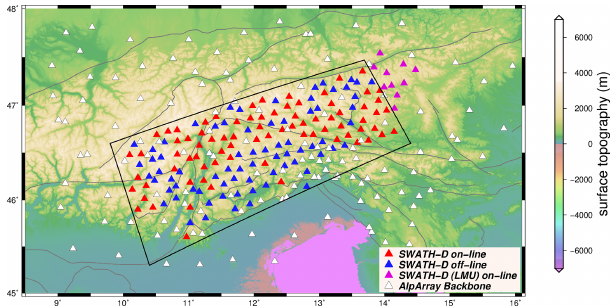
Figure 2. Distribution of seismic stations of the SWATH-D network (red, blue, purple) and selected stations of the AASN (white). The black box indicates the periphery of the SWATH-D network. The faults are from Schmid et al. (2004, 2008) and Handy et al.